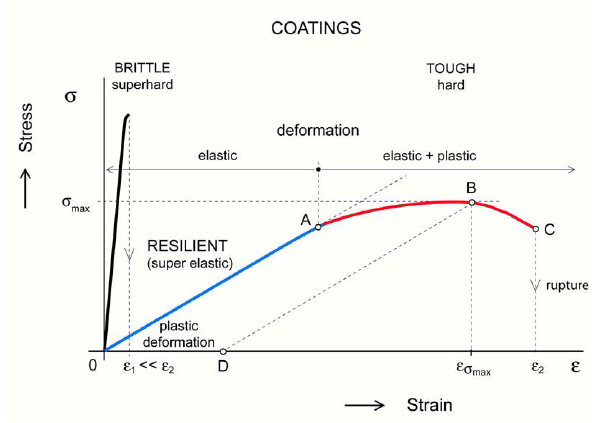
Figure 3: Stress vs strain curves of superhard (brittle), hard (tough) and hard (resilient) coatings [27]